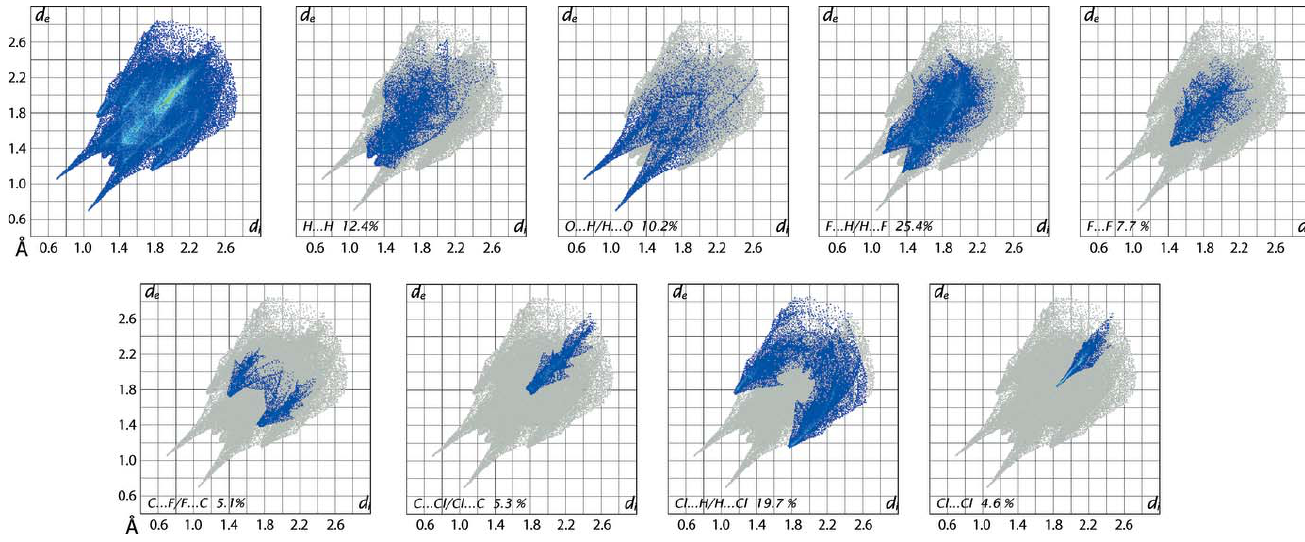
Figure 7 The full two-dimensional fingerprint plot for (I) and those delineated into H (cid:2)(cid:2)(cid:2) H, O (cid:2)(cid:2)(cid:2) H/H (cid:2)(cid:2)(cid:2) O, F (cid:2)(cid:2)(cid:2) H/H (cid:2)(cid:2)(cid:2) F, F (cid:2)(cid:2)(cid:2) F, C (cid:2)(cid:2)(cid:2) F/F (cid:2)(cid:2)(cid:2) C, C (cid:2)(cid:2)(cid:2) Cl/Cl (cid:2)(cid:2)(cid:2) C, Cl (cid:2)(cid:2)(cid:2) H/H (cid:2)(cid:2)(cid:2) Cl and Cl (cid:2)(cid:2)(cid:2) Cl Table 2, which are characterized as the pair of short spikes at (cid:6) 2.5 A˚ in the corresponding delineated fingerprint d + d e i (cid:6) 2.8 A˚ in the fingerprint + d plot. An arrow-like tip at d e i delineated into F (cid:2) (cid:2) (cid:2) F contacts is due to the effect of the short interatomic F (cid:2) (cid:2) (cid:2) F contact summarized in Table 2. The presence of short interatomic C (cid:2) (cid:2) (cid:2) F/F (cid:2) (cid:2) (cid:2) C contacts, Table 2, and C—F (cid:2) (cid:2) (cid:2) (cid:2) contacts (Table 1) involving fluoride atoms substituted at the methyl-C10 atom is evident from the forceps-like distribution of points in the fingerprint plot delineated into these contacts. The C—Cl (cid:2) (cid:2) (cid:2) (cid:2) contact, Table 1, spear-shaped distribution of points with the pair of adjoining (cid:6) 3.5 A˚ in the fingerprint plot delineated into tips at d + d e i C (cid:2) (cid:2) (cid:2) Cl/Cl (cid:2) (cid:2) (cid:2) C contacts. Although the interatomic Cl (cid:2) (cid:2) (cid:2) H/ H (cid:2) (cid:2) (cid:2) Cl and Cl (cid:2) (cid:2) (cid:2) Cl contacts make significant contributions to